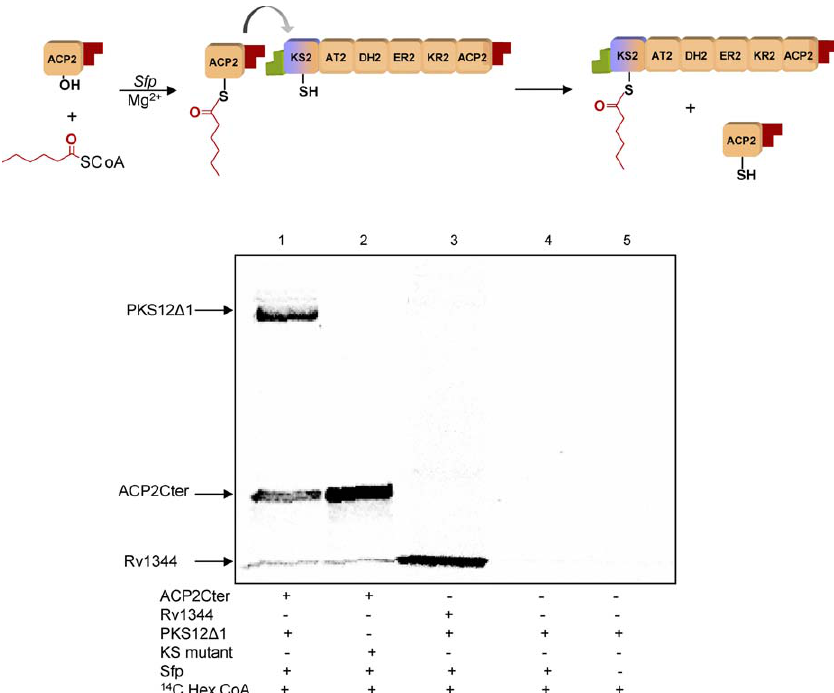
Figure 9. ACP to PKS Transfer Assays Sfp from B. subtilis was used to label ACP2Cter of PKS12 (lane 1 and 2) and a noncognate ACP protein, Rv1344, from M. tuberculosis with 14 C hexanoyl CoA. Although ACP2Cter was able to transfer the label to PKS12 D 1 (lane 1), no transfer was seen when either the KS mutant of PKS12 D 1 was used (lane 2) or when a noncognate ACP with PKS12 D 1 was used (lane 3). Minus ACP control experiment did not show any label on PKS12 (lane 4); there was also no direct labeling of PKS12 D 1 observed (lane